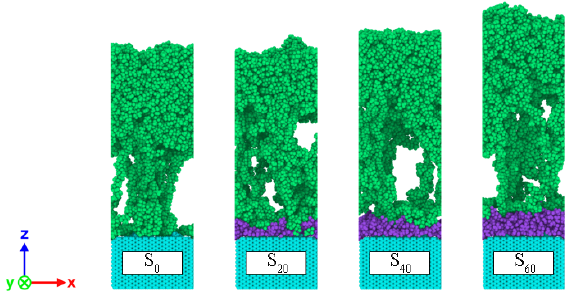
Figure 13. Failure modes of the S i interface system during uniaxial tensile deformation simulation at 40 ps.